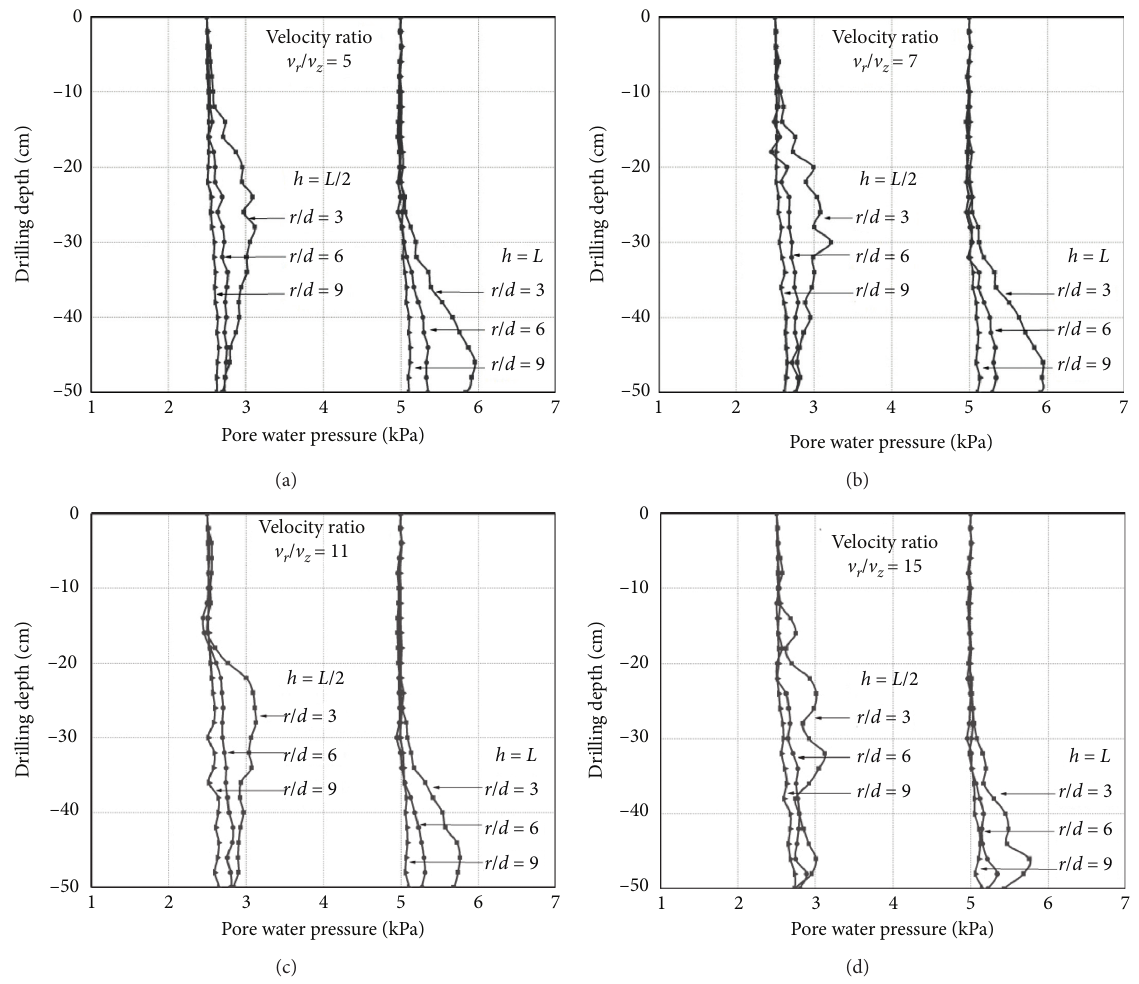
Figure 9: The pore water pressure at the middle and bottom of the pile varies with the drilling